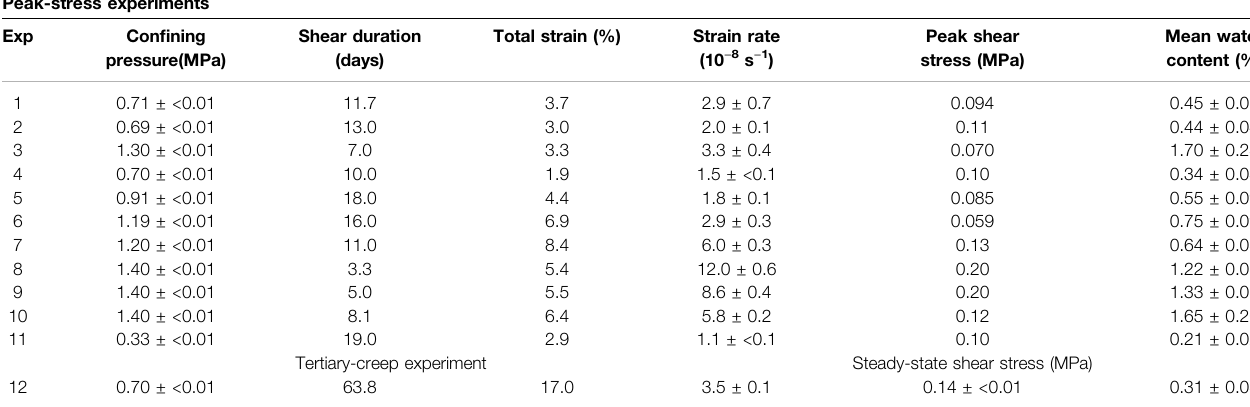
TABLE 1 | Summary of experimental parameters. Reported errors are ± one standard deviation. Peak-stress